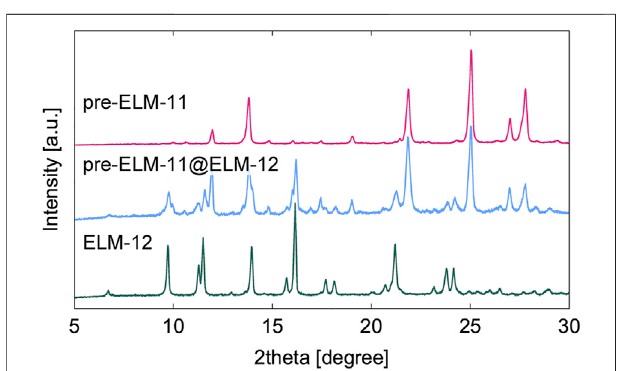
FIGURE 6 | XRD patterns of as-synthesized pre-ELM-11@ELM-12 particles in comparison with those of pre-ELM-11 and ELM-12